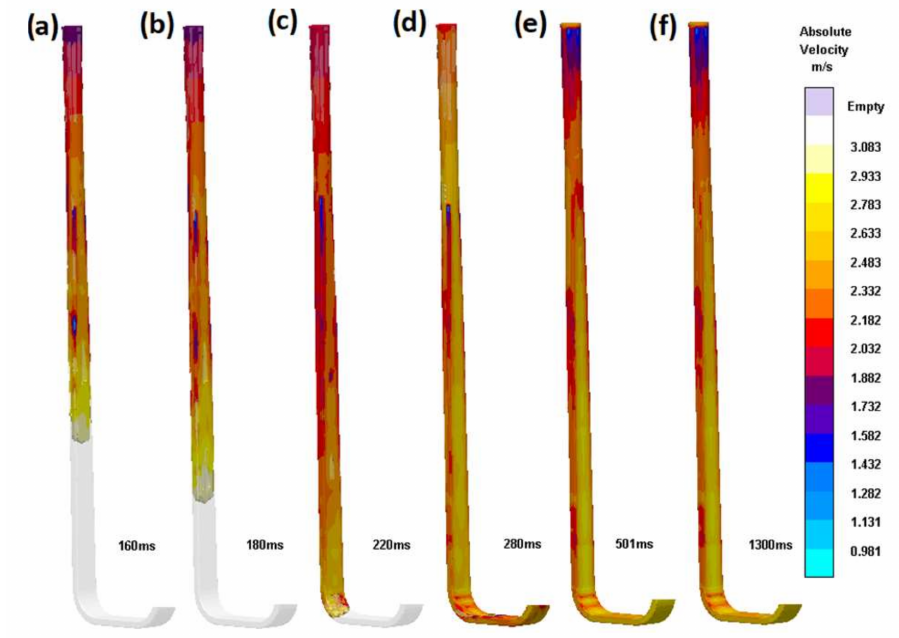
Figure 12. Transitional sprue with proper transition (S i 4). Subsequent stages of the flow ( a ) 160